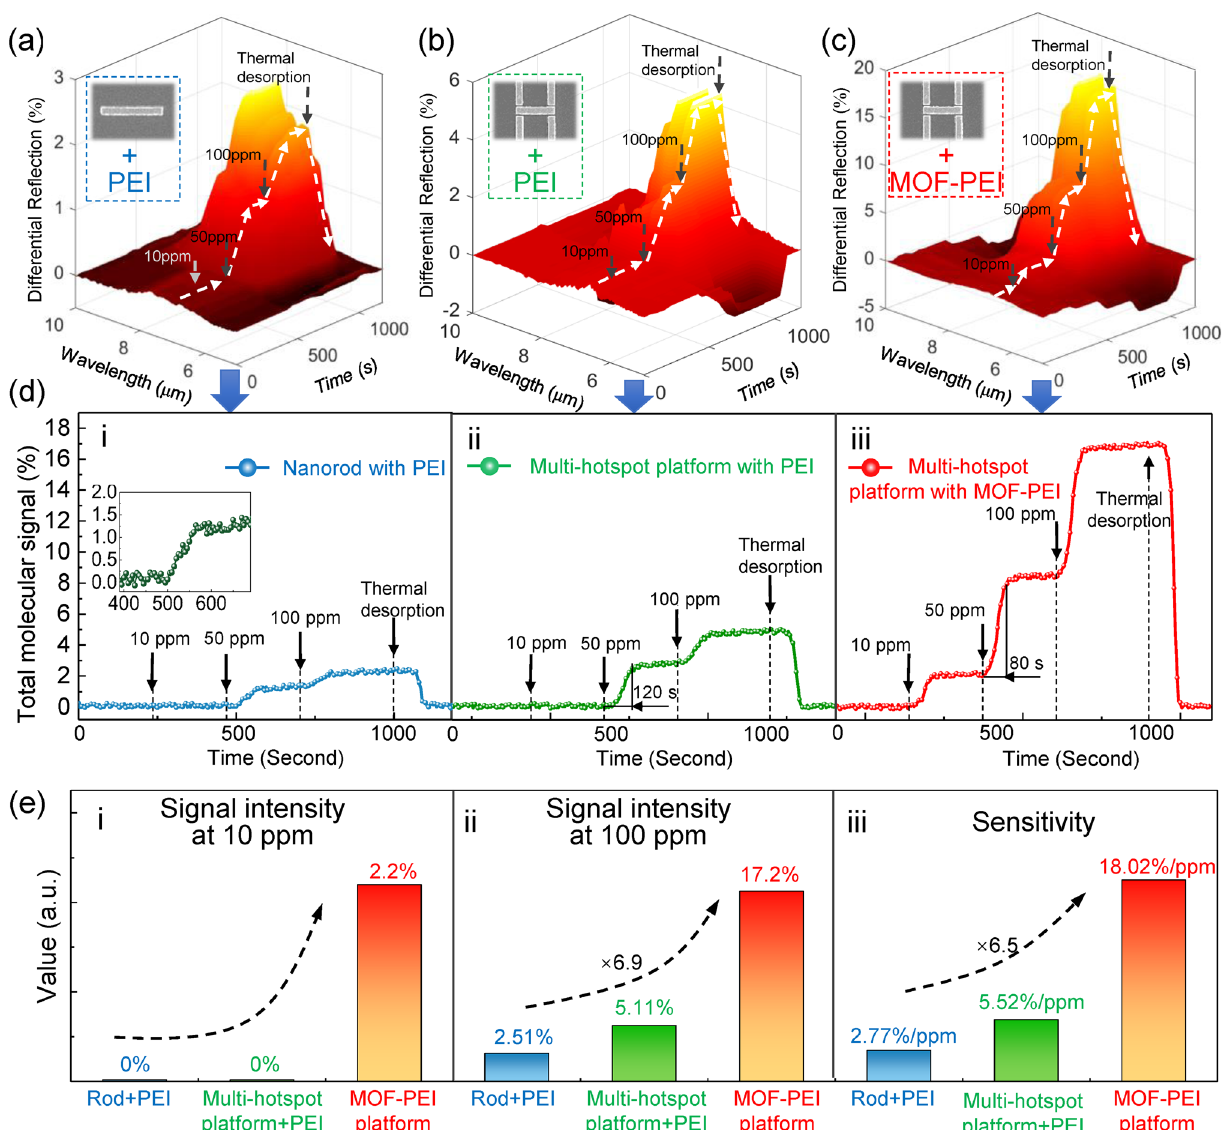
Fig. 7 Dynamic behavior of sensing platforms. a Real-time 3D plots of the differential spectra of platforms using PEI-coated nanorods, b PEI- coated multi-hotspot antennas, and c MOF-PEI-functionalized multi-hotspot antennas, when CO 2 gases with various concentrations are loaded and thermally desorbed. d Temporal variation in the total molecular signal corresponding to ( a‑c ), revealing the dynamic behavior of various platforms. i: PEI-coated nanorod platform; ii: PEI-coated multi-hotspot platform; iii: MOF-PEI-functionalized multi-hotspot platform. e Perfor- mance comparison corresponding to ( d ). i: spectral signal intensity of platforms after loading 10 ppm CO 2 gas; ii: spectral signal intensity after loading 100 ppm CO 2 gas; iii: sensitivity